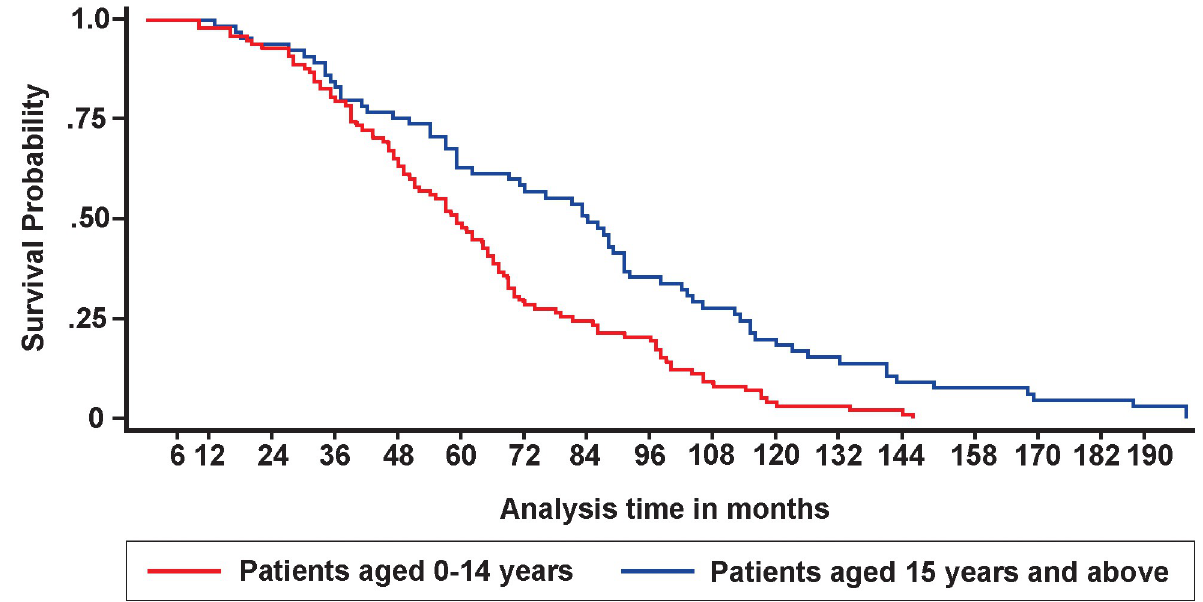
Fig 3. Time to confirmed VTF from ART initiation by age. Kaplan Meier cumulative probability of VTF following ART initiation at different time intervals by age group, patients aged 0–14 years (Red), patients aged 15 years and above (Blue), n = 160.